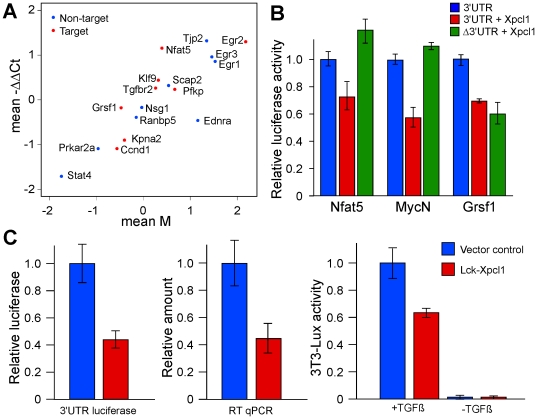
Effect of Xpcl1 on target gene expression.(A) Differences in mRNA expression was measured by qPCR (mean -ΔΔCt) for 17 genes and plotted as the mean difference in PCR cycle number of Xpcl1 positive vs. Xpcl1 negative tumors. This correlated with the changes in genes expression noted on microarrays (mean M, log2(tumor/normal)). Genes with varying levels of change in association with Xpcl1 integration are shown, some of which are predicted targets of miR-106a∼363 (red) and others which are not (blue). Comparison of luciferase activity (B) in reporter constructs containing 3'UTR sequences of miR-106a∼363 predicted target genes: Nfat5, N-myc, and Grsf1. Each 3'UTR reporter construct was cotransfected with either pCIG-Xpcl1 or empty pCIG vector. Xpcl1 was also transfected with reporter constructs with mutations in the seed region of the predicted miRNA target site (Δ3'UTR). Xpcl1 expression reduces luciferase expression associated with the 3'UTR of Tgfbr2 (C), and results in reduced Tgfbr2 mRNA levels as measured by qPCR. Xpcl1 reduces downstream signaling in response to TGF-beta (right panel C) as measured by activity of the 3T3-Lux reporter construct. (Barplots are means ± SE).